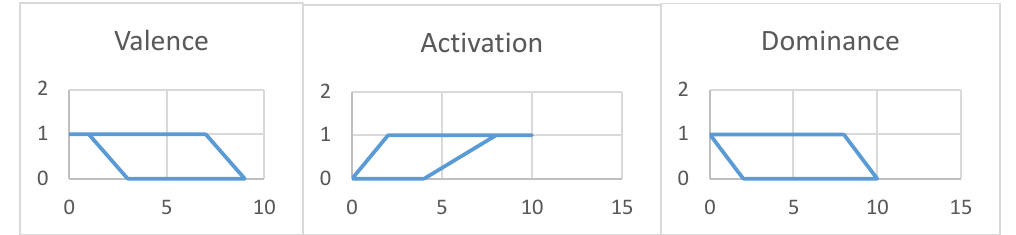
Fig. 7. The FOU of Akwa Uta (Remorse) for dimensions valence, activation and dominance.